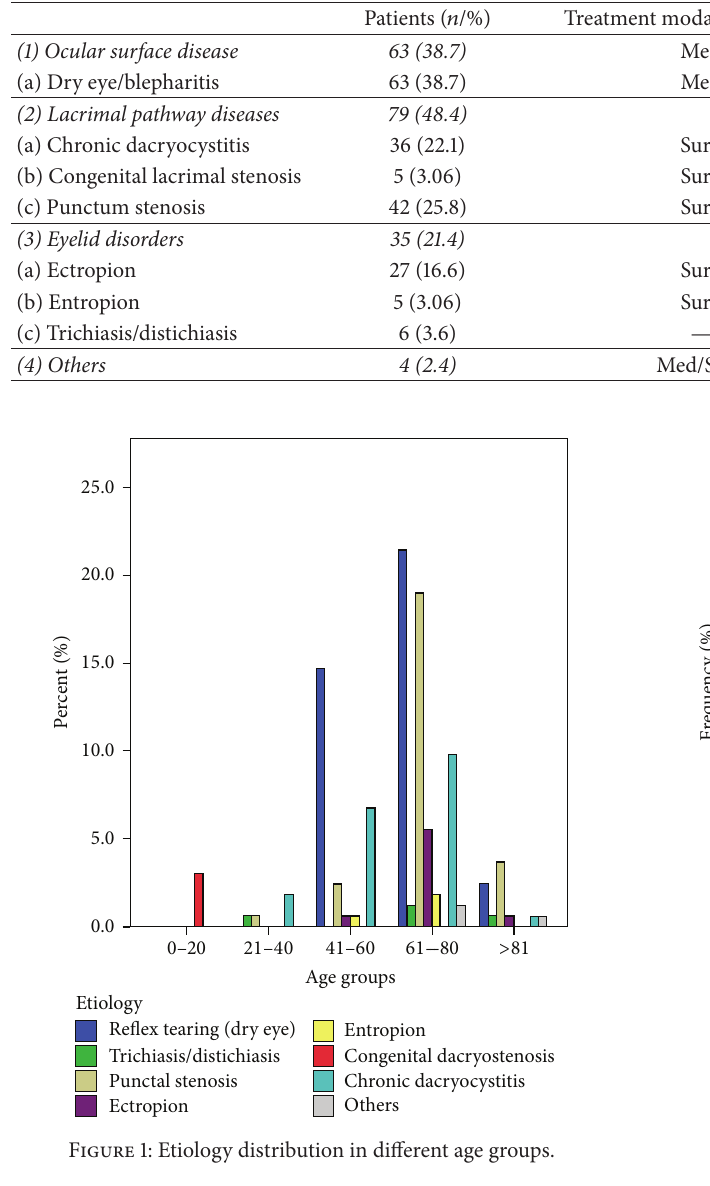
Table 2: Causes of epiphora and the relationship with treatment methods and treatment rates.